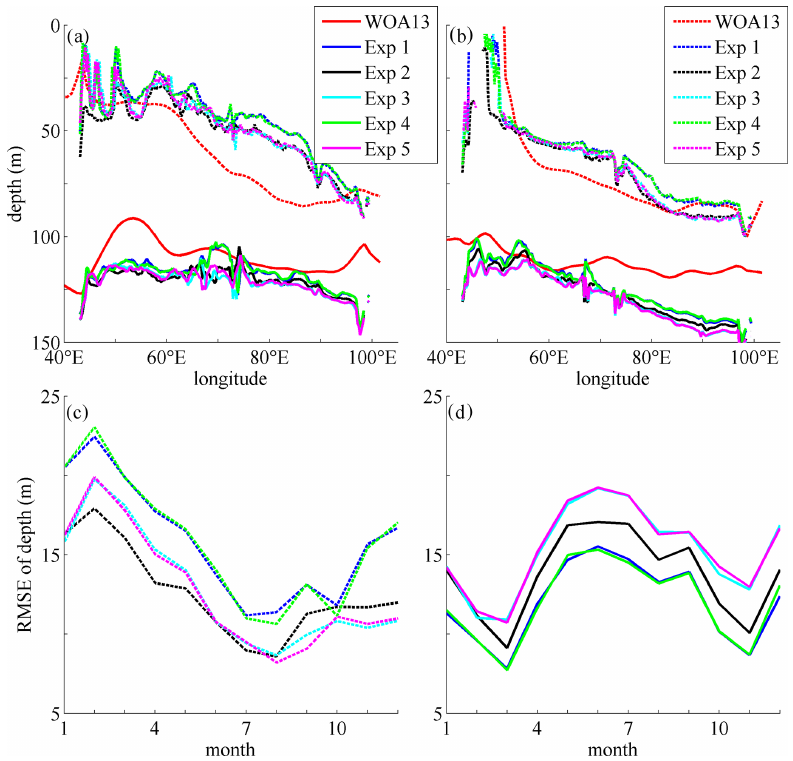
Figure 9. The comparison of Z20 and Z26 depths along the Equator from the WOA13 data and the model results. (a, b) The Z20 (solid curves) and Z26 (dashed curves) depths from the WOA13 data and model results (Exp 1–Exp 5) in January and July, respectively. The RMSEs of the Z26 (c) and Z20 (d) depths along the Equator in the whole climatologic year are also